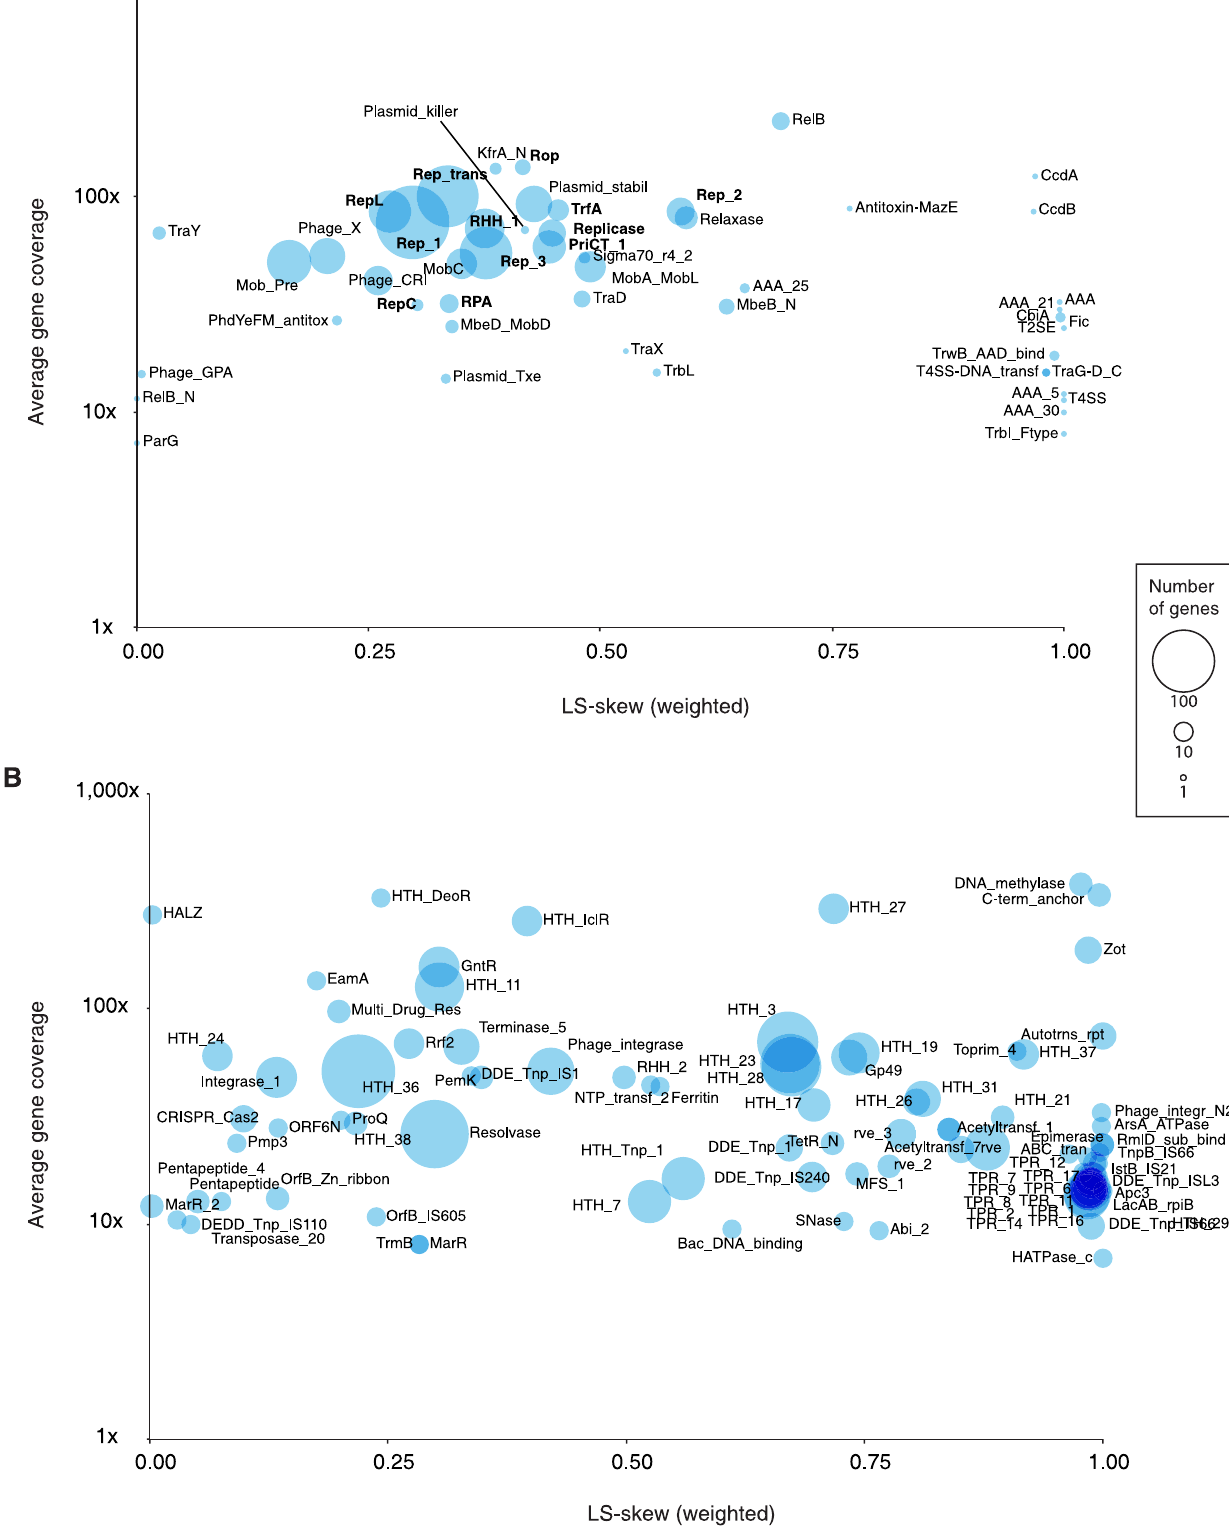
Figure 3. Bubble diagram showing occurrences of known protein-family domains (Pfams) associated with either plasmid-selfish (a) or non-plasmid-selfish (b) functions among 1,119 genes predicted from a de novo assembly made from two wastewater metamobilomes. The two samples were isolated with either an established method (S) or a modified method using electroelution (L; this study).